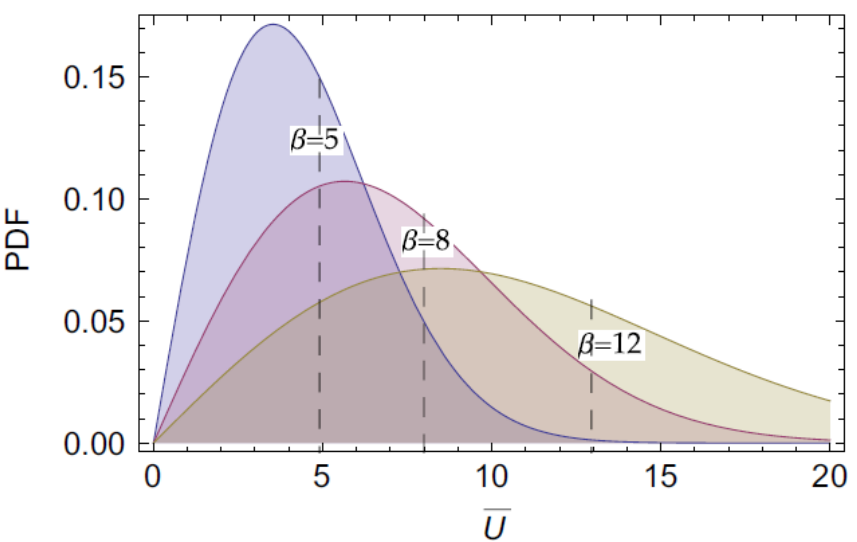
Figure 3. Wind speed in m/sec distribution examples, Weibull probability density functions, from [16].